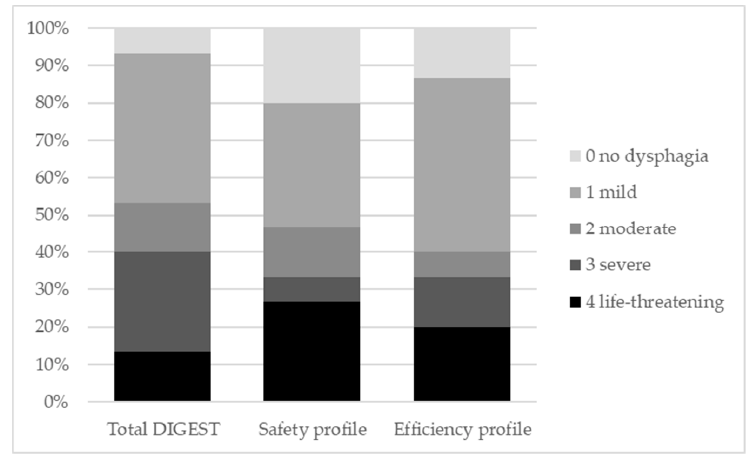
Figure 1. Distribution of the 15 patients with open partial horizontal laryngectomy (OPHL) type IIa and extension to include one arytenoid ( + ARY) in the Dynamic Imaging Grade of Swallowing Toxicity (DIGEST) levels.